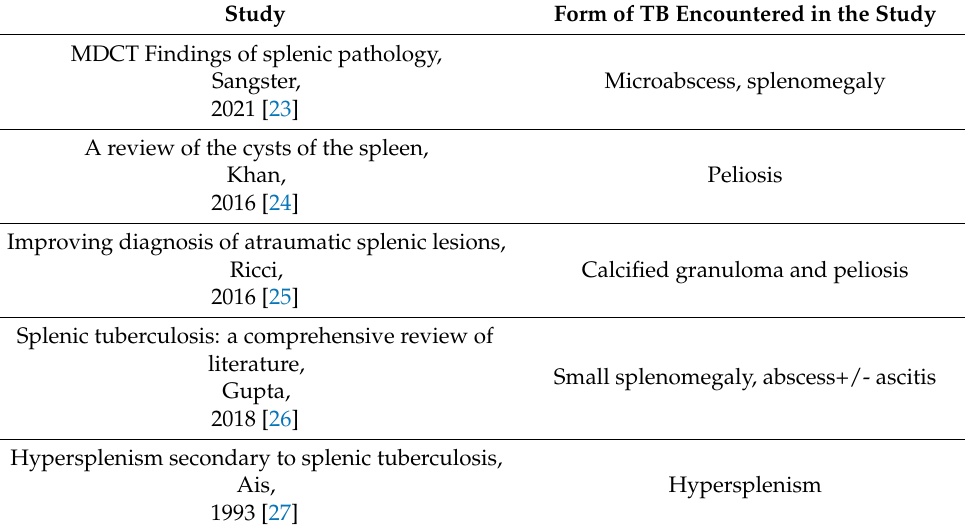
Table 5. Splenic tuberculosis: literature studies and their key features.